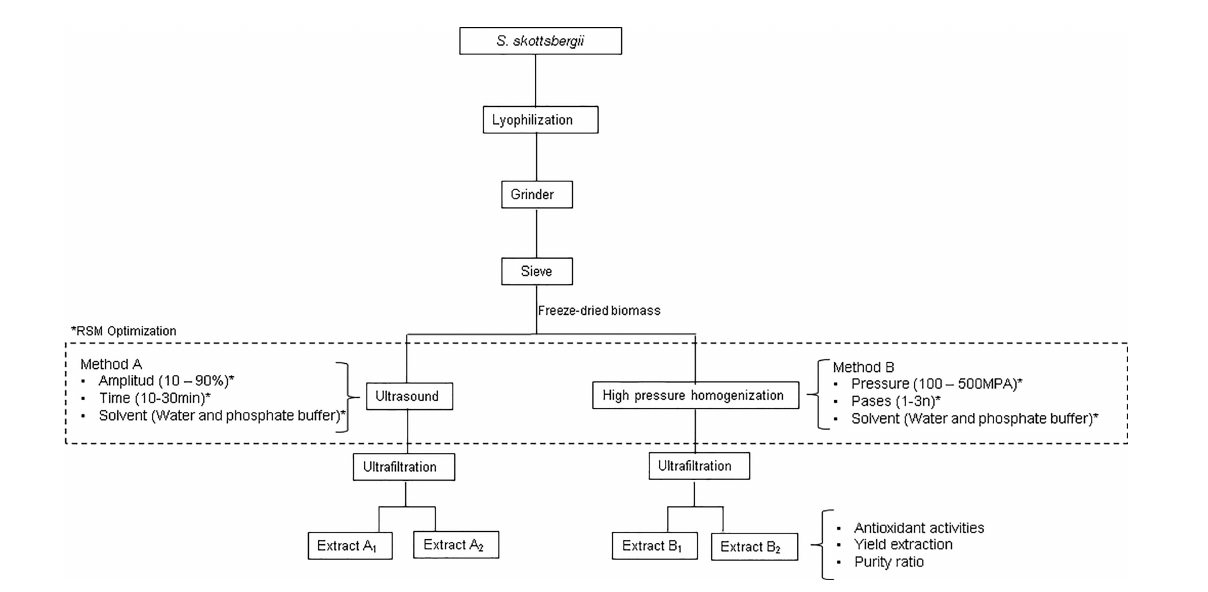
FIGURE 1 | Summarizing scheme of the procedure for the extraction of R-Phycoerythrin from S. skotts . *RSM Optimization.